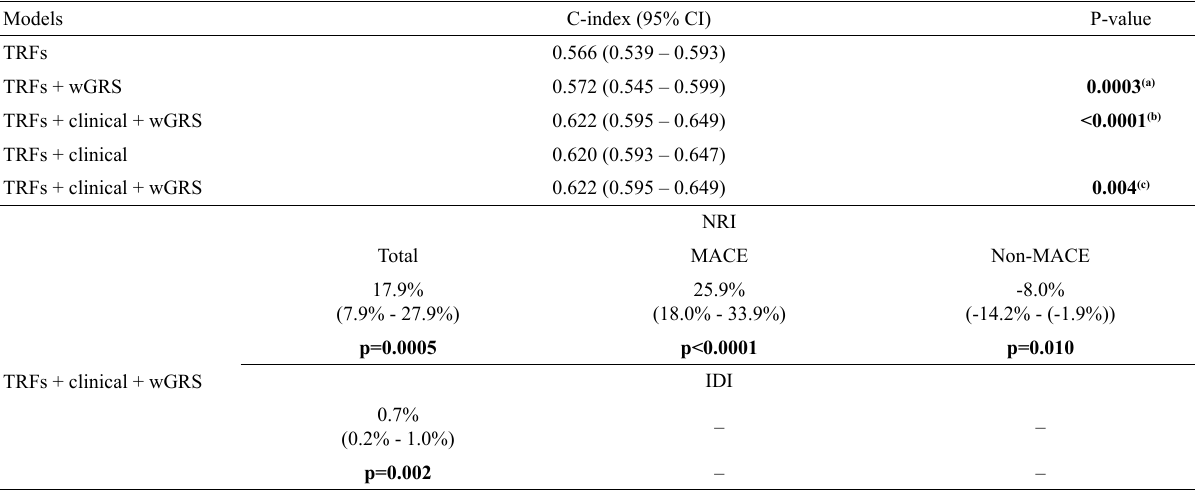
Table 4 ‒ MACE discrimination using Harrel’s C-statistic, NRI and IDI methodology. Models